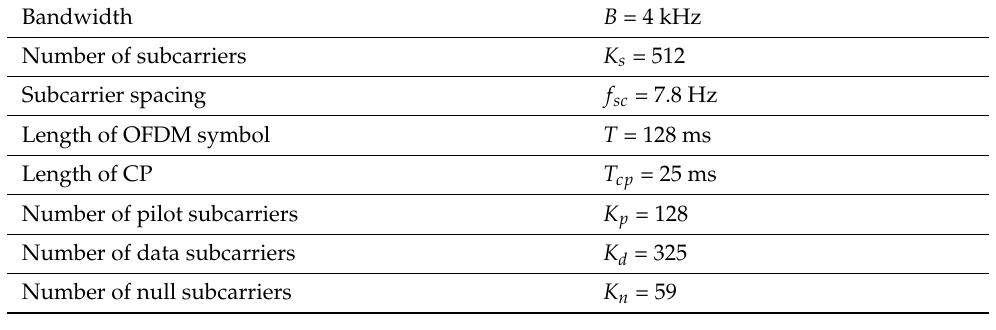
Table 2. Parameter used in frame-based adaptive modulation during tank experiment.